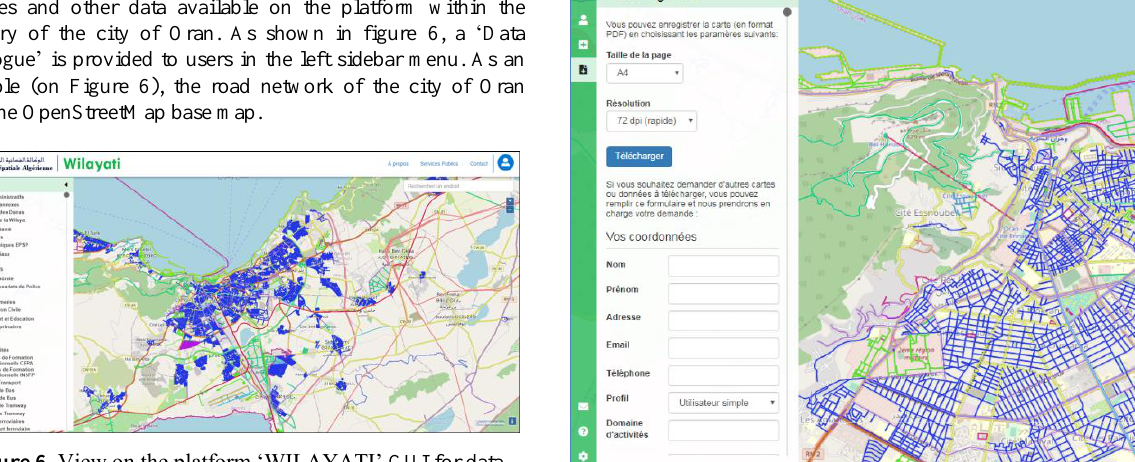
Figure 6 . View on the platform ‘WILAYATI’ GUI for data visualisation. Example: Map of the OSM road network of the city of Oran.